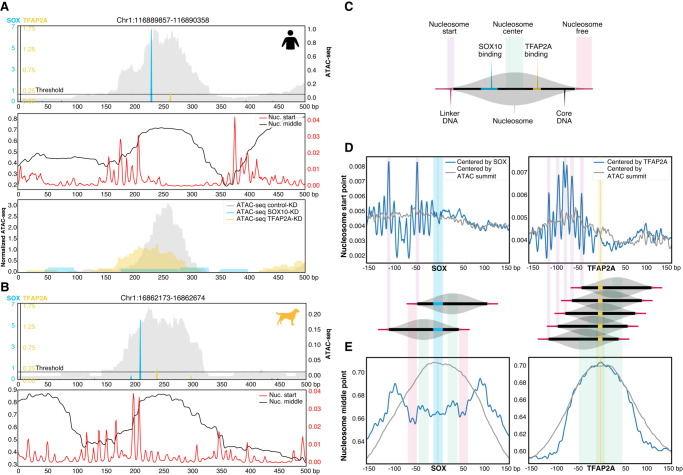
Positional specificity of SOX10 and TFAP2A in MEL melanoma enhancers. (A,B, top) Example human (A) and dog (B) MEL-predicted enhancer containing significant SOX10 and TFAP2A motifs. The ATAC-seq signal is shown in gray. (A, middle; B, bottom) Imputed nucleosome start and middle point profiles. (A, bottom) For the human example region, ATAC-seq profiles of MM001 in control condition, after 72 h of SOX10 knockdown or TFAP2A knockdown are shown. (C) Schematic overview of the nucleosome structure explaining the colors used in D and E. (D,E) Nucleosome start point (D) and nucleosome middle point predictions (E) on MEL-predicted regions containing one SOX10 (left) or one TFAP2A motif (right) next to possible other motifs, where the regions are either centered on the ATAC-seq summit (gray) or on the SOX10 or TFAP2A motif (blue).